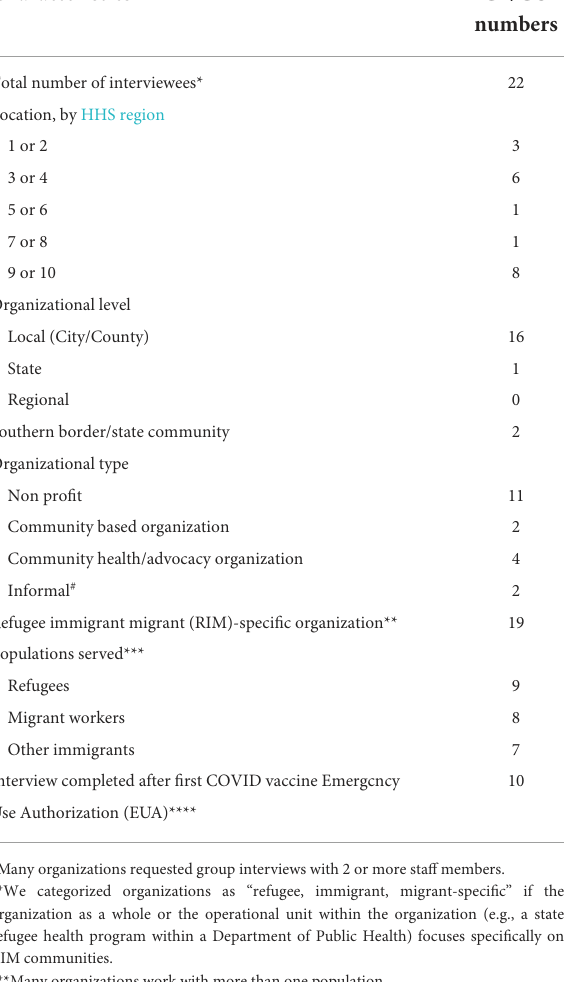
TABLE 1 Demographic characteristics of community expert/community organization (CE/CO) participants.